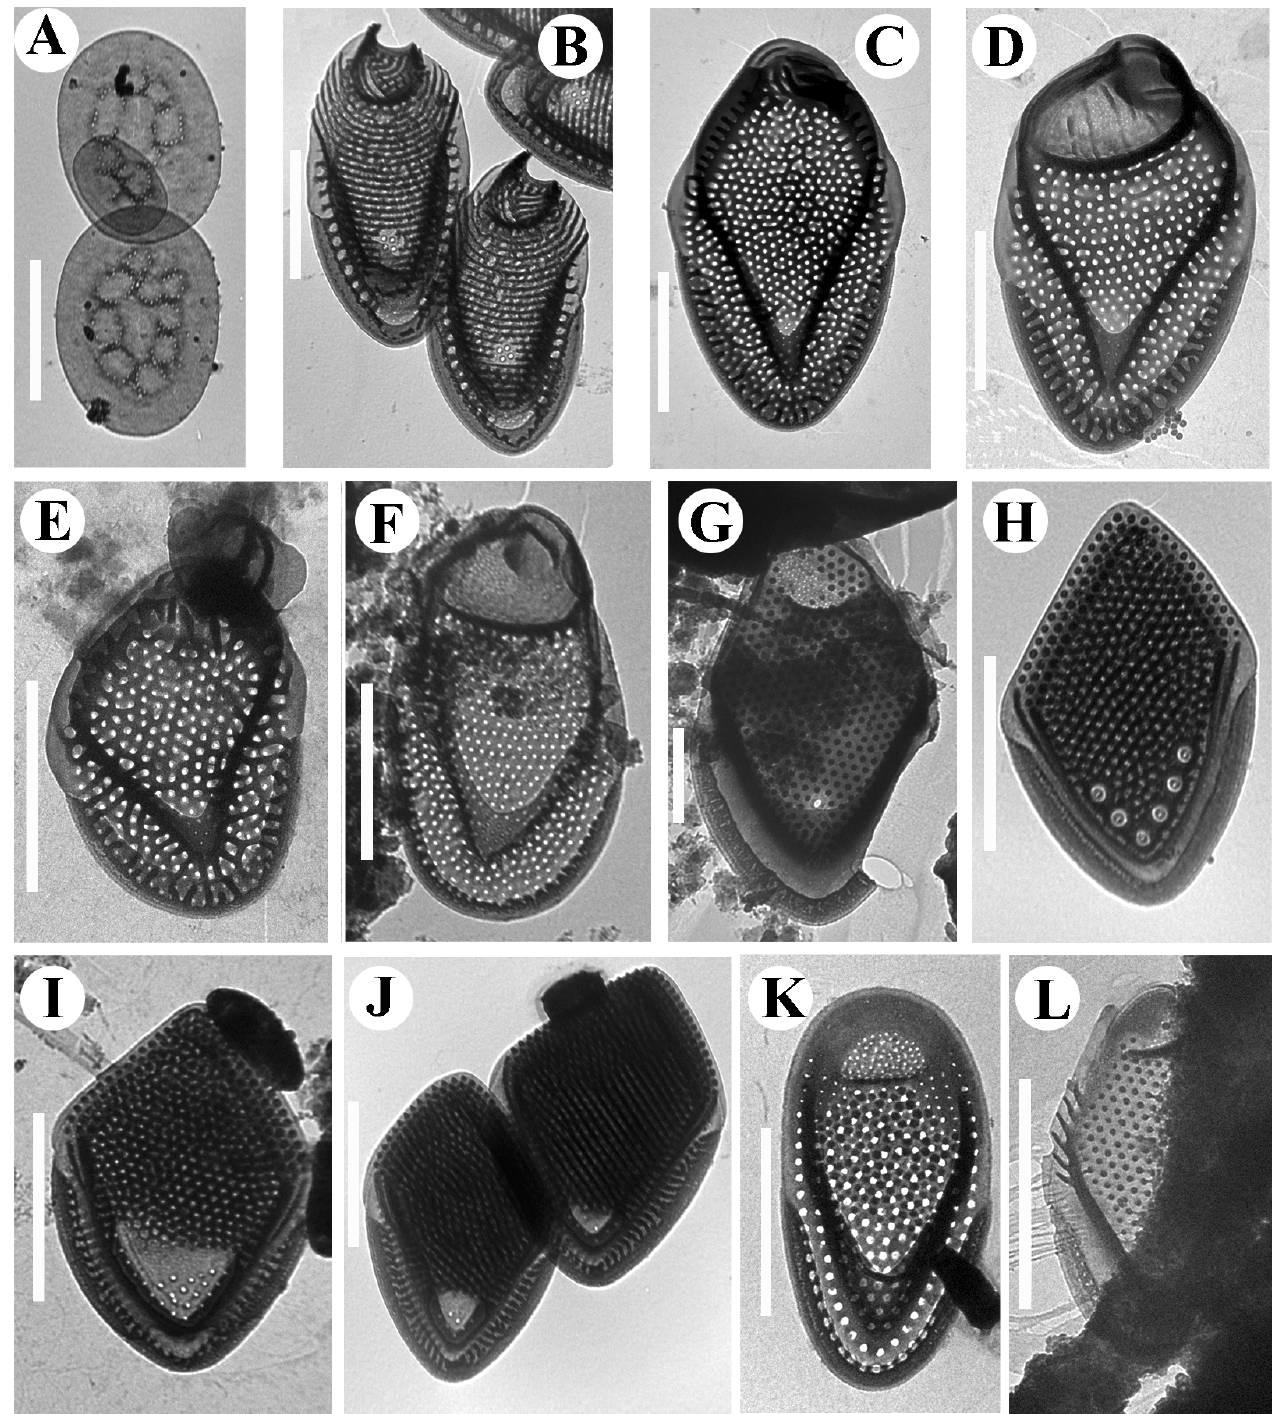
Figure 3. ( A – L ) Chrysosphaerella and Mallomonas taxa from Indonesian Papua, TEM. ( A ) Chrysosphaerella annulata , plate-like scales. ( B ) Mallomonas cratis , a group of scales. ( C – E ) Mallomonas cyathellata , dome- less scale ( C ), domed scale ( D ) and rear scale ( E ) with cyathus (arrow). ( F ) Mallomonas cf. elongate . ( G ) Mallomonas furtiva . ( H ) Mallomonas mangofera var. foveata . ( I , J ) Mallomonas mangofera var. reticulata . ( K ) Mallomonas multisetigera . ( L ) Mallomonas papillosa . Scale bars: ( A – F , H – L ): 2 µ m, ( G ): 1 µ